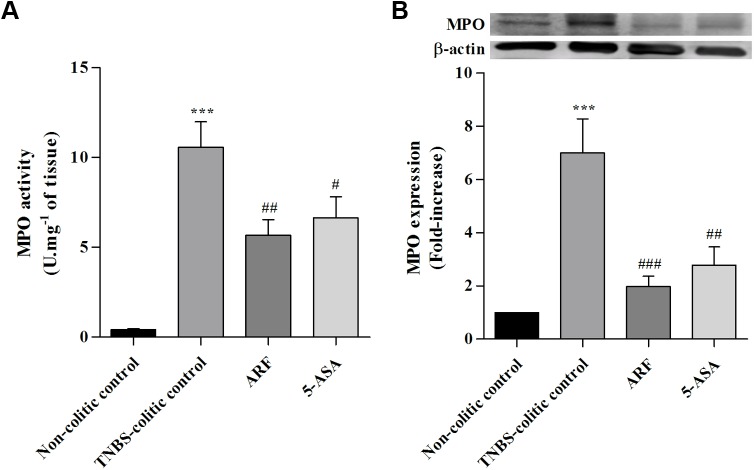
Effect of anthocyanin extract administration on colon myeloperoxidase activity and expression as compared with 5-ASA, in TNBS-induced colitis.MPO activity (A) was measured in colon tissue homogenates and expressed in units of enzyme activity per mg of tissue. MPO protein expression (B) was assessed in colon tissue samples by Western blotting and expressed as fold increase relative to the non-colitic control group. Values are mean ± SEM from at least 8–9 animals per group, each one in duplicate. ***P<0.001 vs non-colitic control; #P<0.05, ##P<0.01, ###P<0.001 vs TNBS-colitic control.